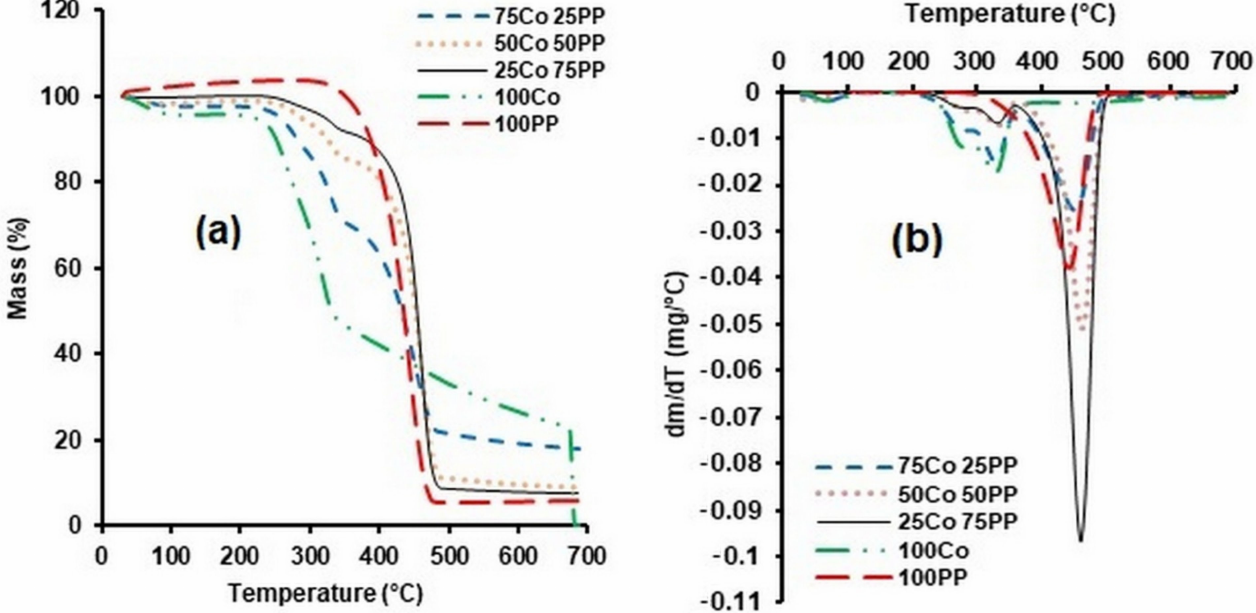
Figure 1. TG curves ( a ) and DTG curves ( b ) for coir fibres, polypropylene, and biocomposite